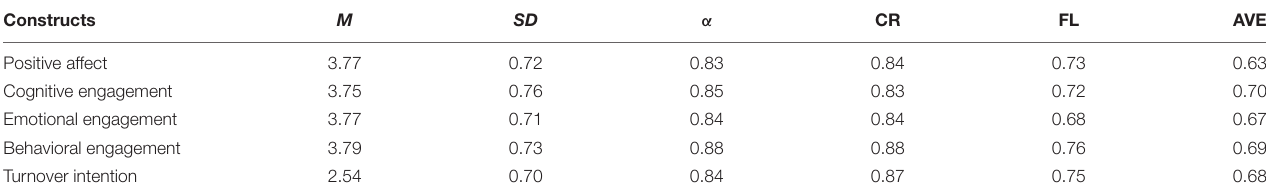
TABLE 2 | Construct reliability and validity analysis ( n = 386).